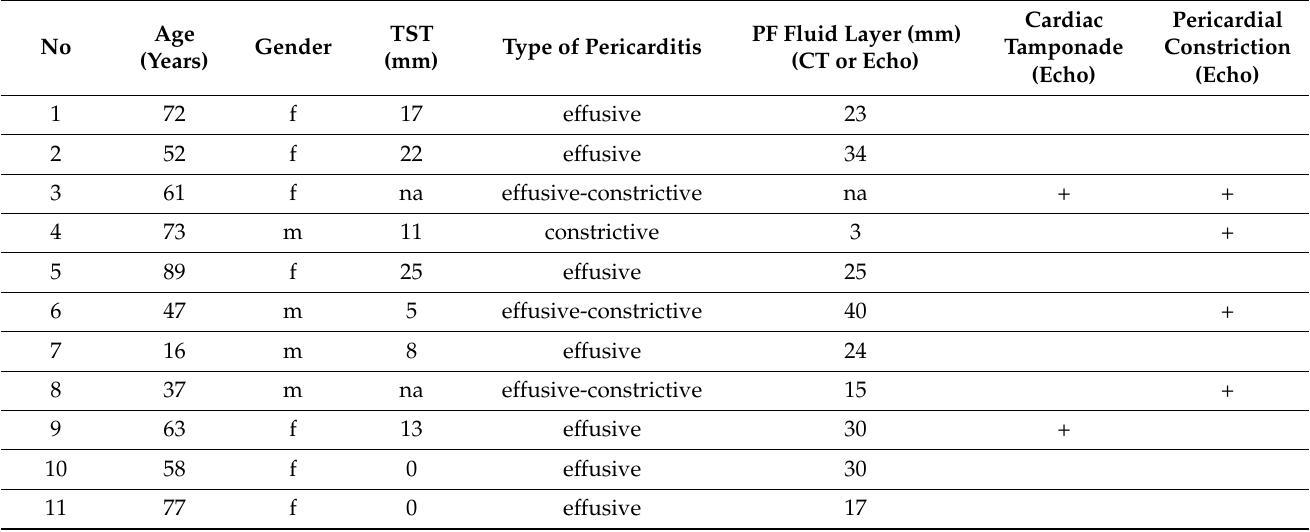
Table 1. Clinical and imaging characteristics of 11 patients with tuberculous pericarditis.